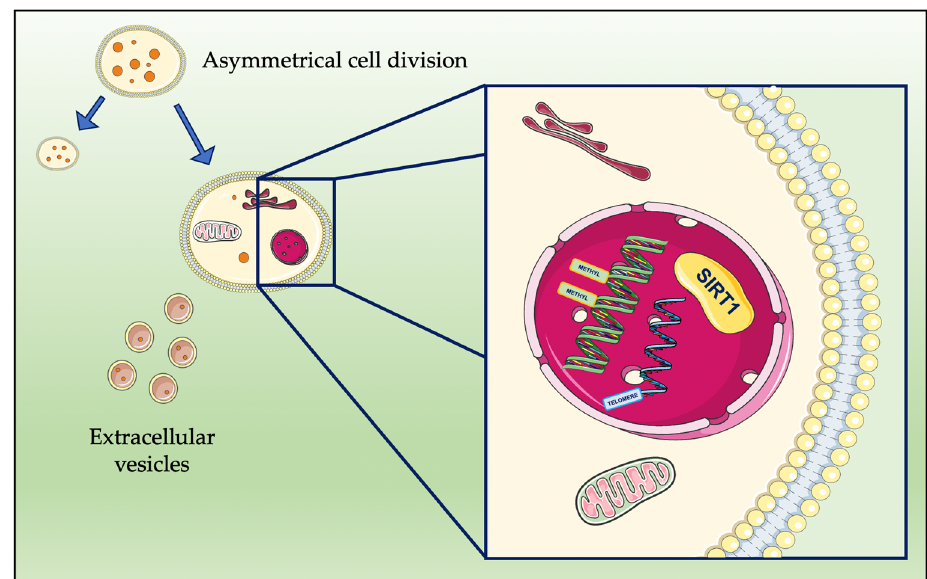
Figure 2. Schematic representation of the cellular events mediating rejuvenation. Asymmetrical cell division and the elimination of extracellular vesicles occur in conjunction with processes that take place in the nucleus; these processes are related to SIRT1 activation, DNA methylation, and telomeres. The artwork was prepared using resources from Servier Medical Art (smart.servier.com, Accessed on 15 January 2023).